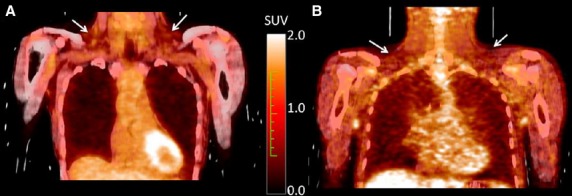
FDG PET/CT images of a female (A) and a male (B) runner show low FDG uptake in supraclavicular adipose tissue depots (white arrows). The maximal FDG SUV in these depots was determined as 1.5 in the female and 0.7 in the male runner.